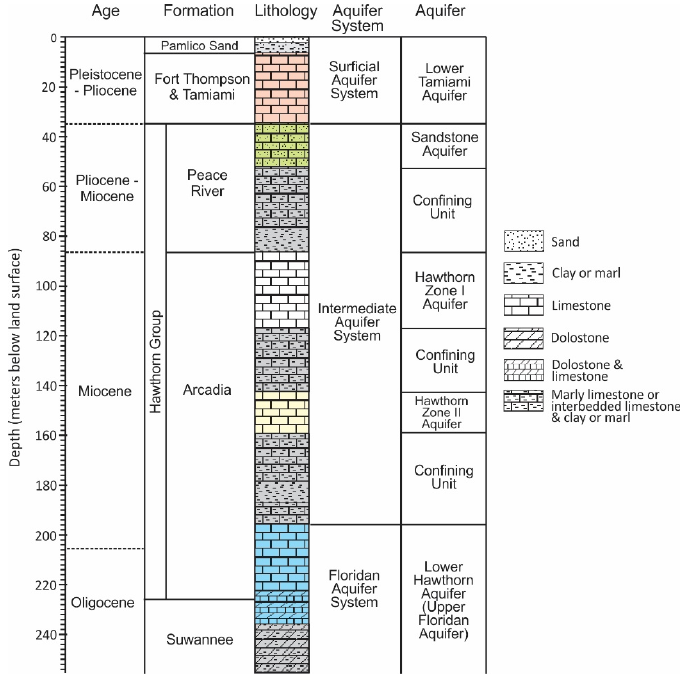
Figure 2. Hydrogeology of Hawthorn Aquifer Zone 1 and the Lower Hawthorn Aquifer [32]. Water 2021 , 13 , x FOR PEER REVIEW